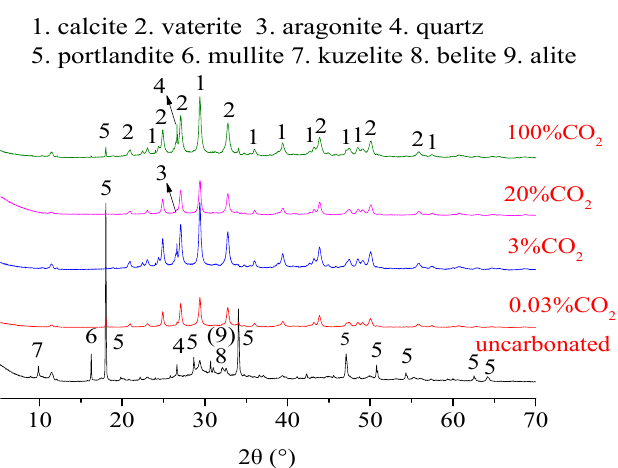
Figure 3. X-ray di ff raction patterns of slag blended pastes with and without carbonation under di ff erent Figure 3. X-ray diffraction patterns of slag blended pastes with and without carbonation under CO 2 different CO 2 concentrations.